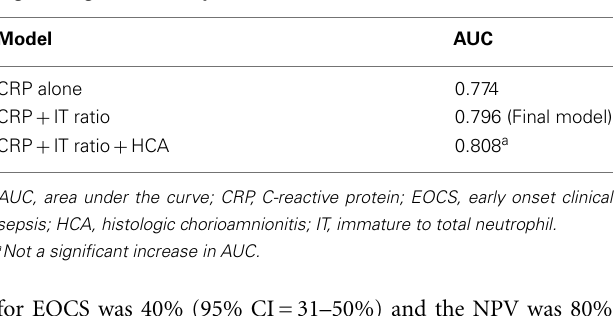
Table 2 | Best model for predicting EOCS using stepwise multiple logistic regression